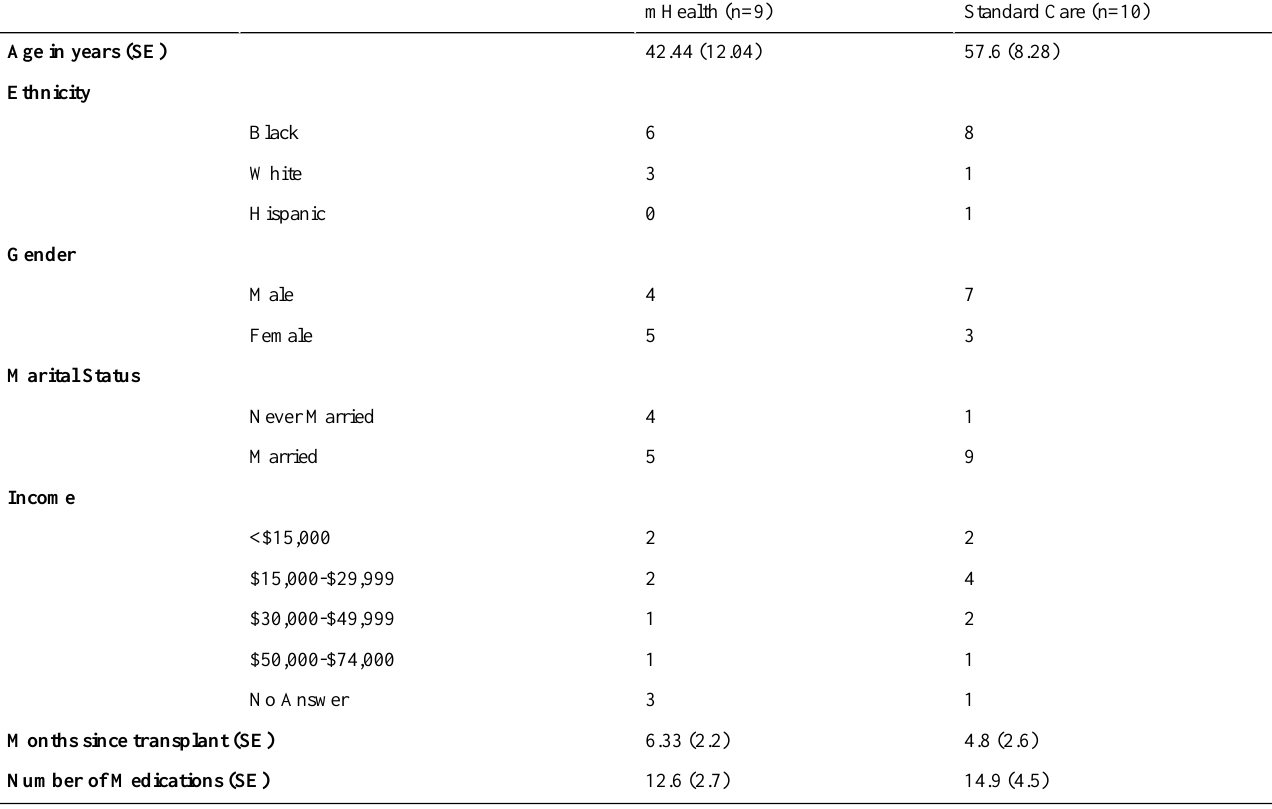
Table 1. Descriptive characteristics of